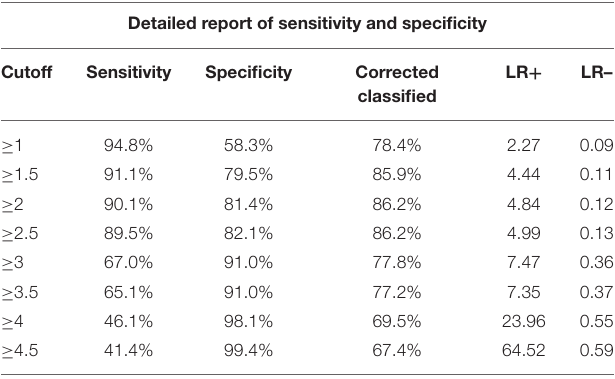
TABLE 4 | Predictive scoring system cutoff detailed report performance. Detailed report of sensitivity and